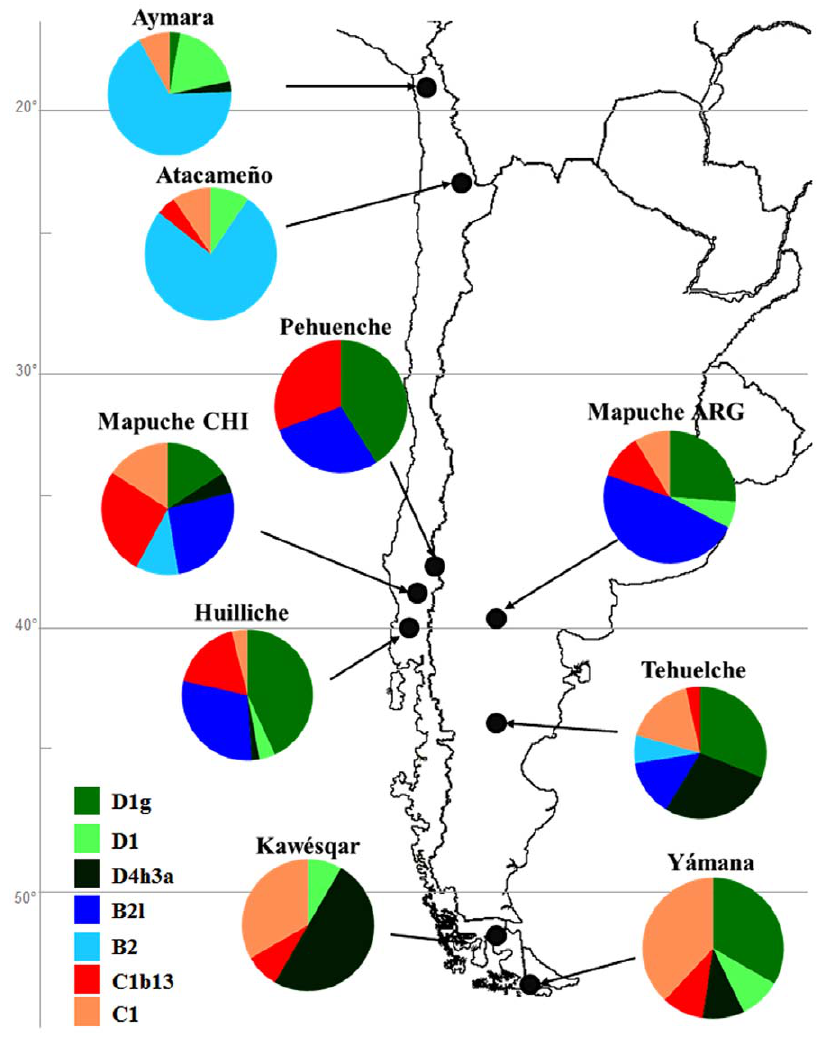
Figure 1. Haplogroup linage map for each population studied. Haplogroup A2 is not included, due to its low representation in these populations. Note the large differences in frequency for D1g, B2l and C1b13 between northern and southern populations.